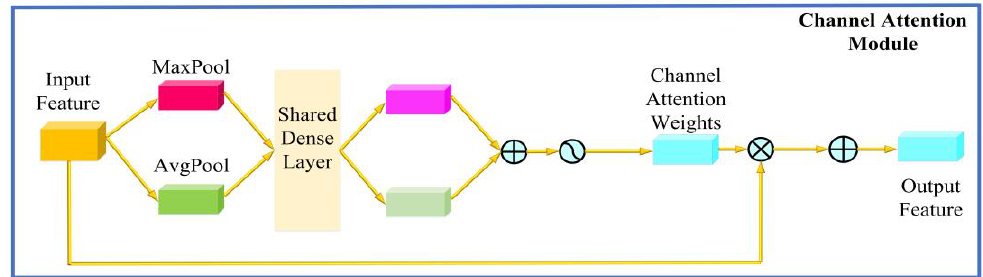
Figure 6. Channel attention model structure.